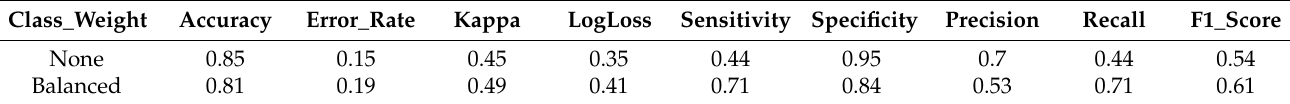
Table 8. Metrics for class_weight parameter.